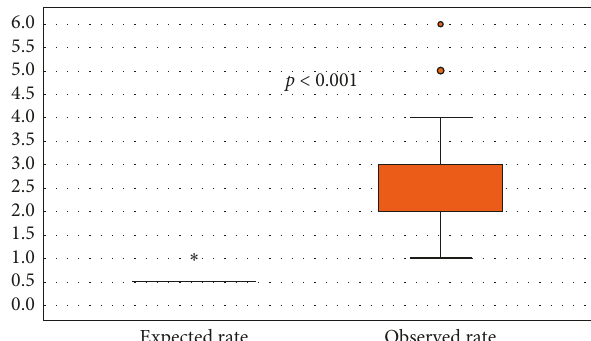
Figure 2: Expected vs. observed length of hospital stay (days).